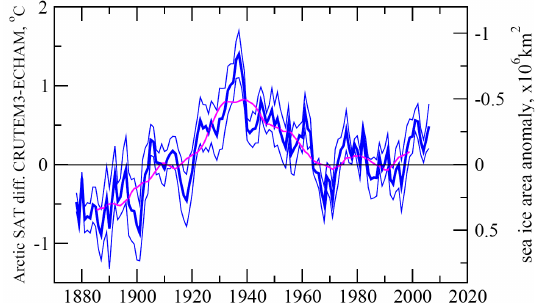
Fig. 7. Ensemble mean difference ( ◦ C) between Arctic cold season land SAT from the ECHAM5 (HadISST) ensemble (thick blue line) and the observations (CRUTEM3). The thin blue lines show the 95% confidence interval. A 5-yr running mean was applied. The magenta line is ensemble mean difference smoothed with a 15-yr running mean. Left axis is for SAT anomalies; right axis represents sea ice area anomalies (10 6 km 2 ) associated with temperature dif- ference as estimated from model sensitivity